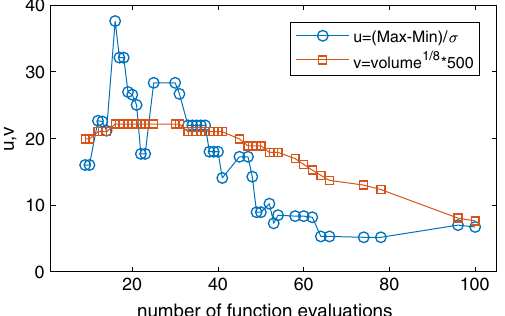
FIG. 6. Evolution of the simplex size as indicated by the u (circles) and v (squares) parameters defined in Eq. (4) during the RSimplex optimization run for the kicker bump matching experiment.